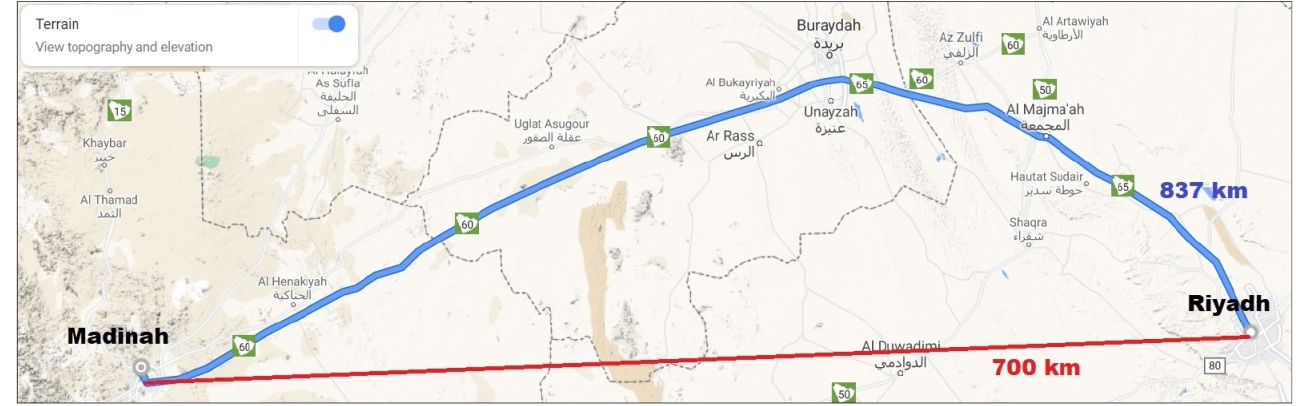
Figure 3. The newly planned road (in red) and the current road (in blue) (Google Maps | Terrain).